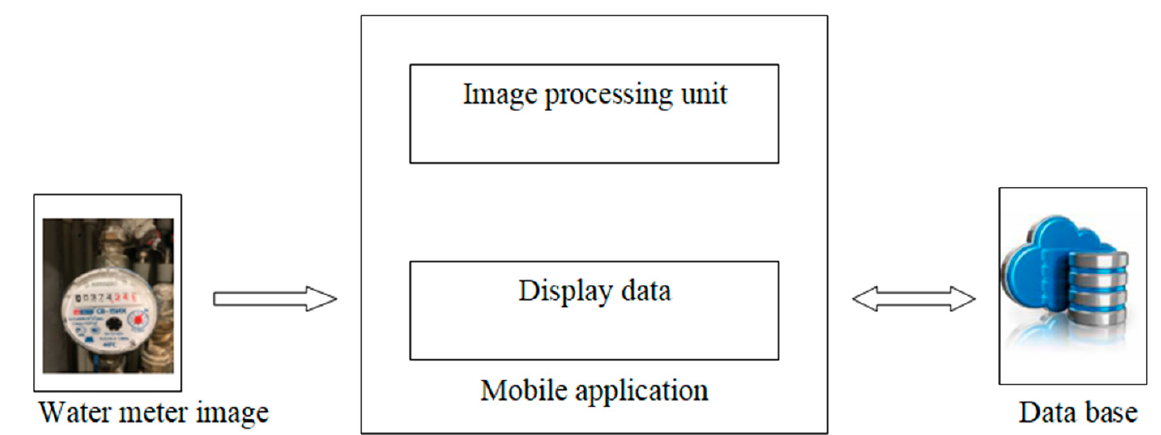
Figure 2. Software